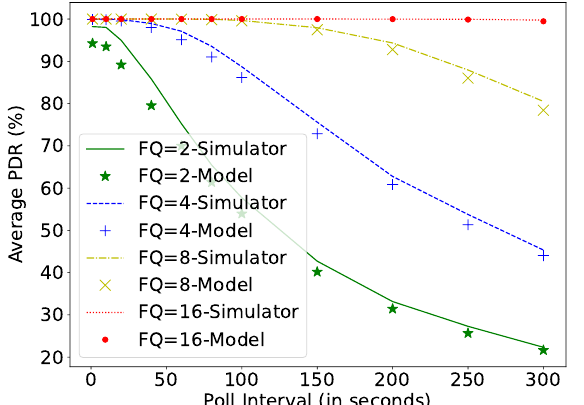
Figure 12. Comparing simulator and model for different poll intervals and FQ at C = 0.1 mF, P h = 0.1 mW, µ p = 30 s, T AT = 0